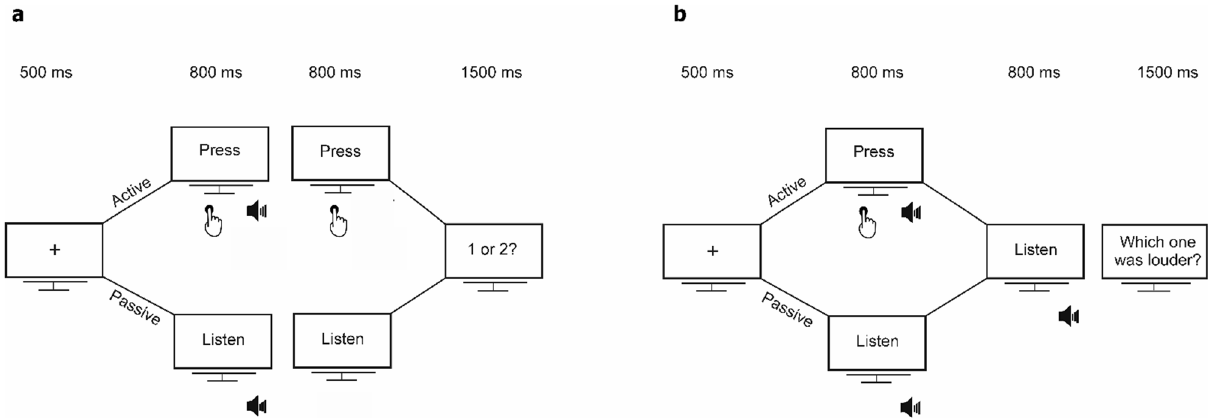
Figure 1. Schematic illustration of the experimental design. ( a ) Detection task : Each trial started with a fixation cross, followed by two intervals. In active trials, participants were instructed to press a button in each interval (“Press” cue) and a sound was triggered either in 1st or in the 2nd one (in the example shown here, the sound is presented in the 1st interval). In passive trials, the sound was passively presented (“Listen” cue). Participants had to respond whether they heard the sound in the 1st or in the 2nd interval. ( b ) Discrimination task : Each trial started with a fixation cross, followed by two sounds. The first sound was either self- (active trials; “Press”